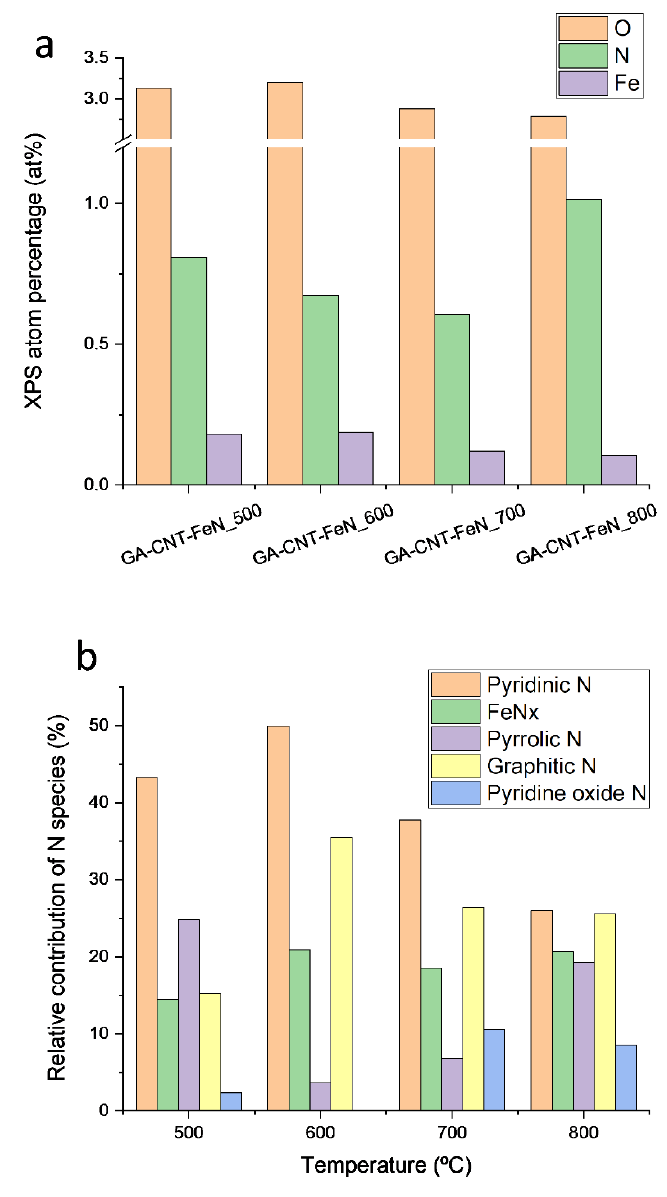
Figure 7. XPS quantification: ( a ) atomic percentages determined by XPS and ( b ) relative contribution of N species determined by N 1s XPS deconvolution.